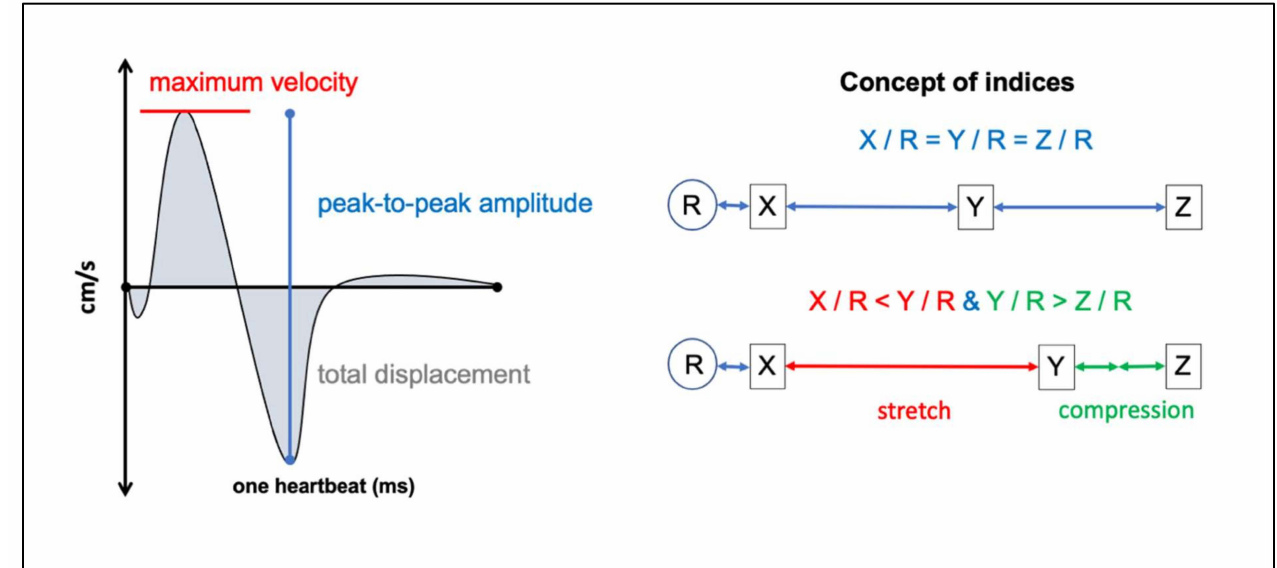
Figure 2. Schematic illustration of the dynamic spinal cord motion parameter based on the approximated 40 velocity values per individual plotted over one heartbeat (left side). Maximum velocity (red) refers to the highest positive (craniocaudal) velocity within the curve. Peak-to-peak-amplitude (blue) addresses the maximum positive (caudal) and negative (cranial) velocity within the curve and therefor adds further information on the extent of the motion. The total displacement (grey) comprises information of the entire curve (addition of the area under the curve irrespective of algebraic signs). Indices allow information beyond general group effects by intra-individual referencing. It minimizes possible general biodynamic confounders and gives information on possible strains (right side). If a point Y in relation to the reference R moves faster than a point X in relation to the reference R, the interjacent material (red arrow) becomes stretched. In case of higher motion of Y in relation to R compared to Z in relation to R, the interjacent material becomes compressed (green